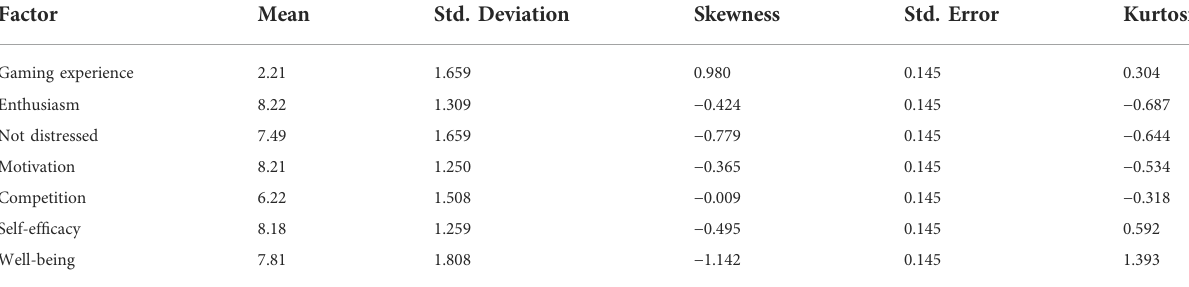
TABLE 2 Measures of state of mind prior to VR training.